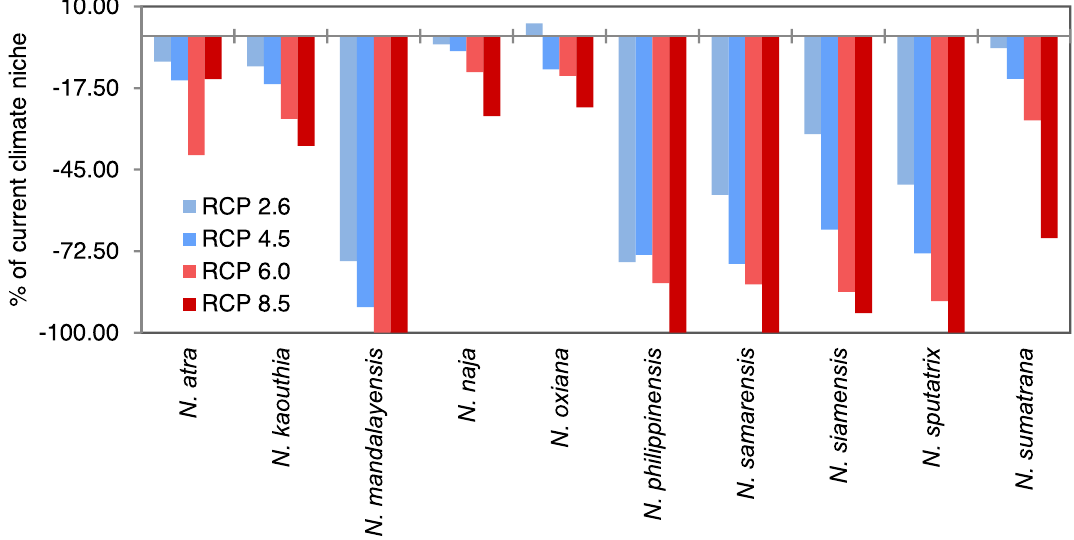
Figure 3. The reduction of the present climatic niche of 10 Asian cobras in four RCP trajectories in a timeframe of the next 50 years.